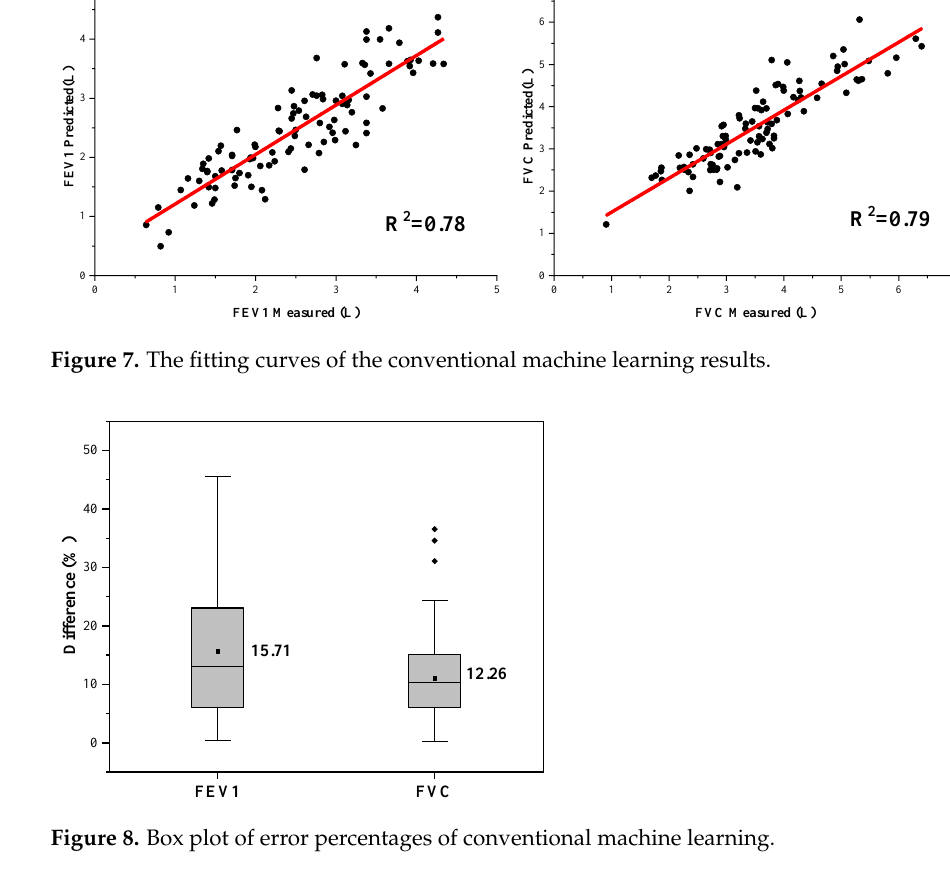
Figure 8. Box plot of error percentages of conventional machine learning. We used a single-structured deep learning algorithm for pulmonary function predic- tion. The CO 2 sequences are processed by a one-dimensional convolutional neural net- work and the results are evaluated using relevant evaluation metrics.